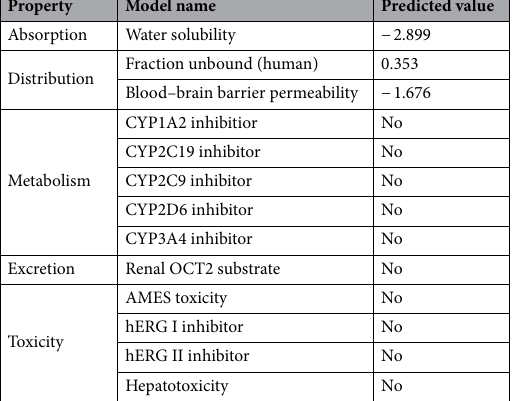
Table 3. pkCSM webserver analysis of ADMET properties for ZINC000104379474 compound.